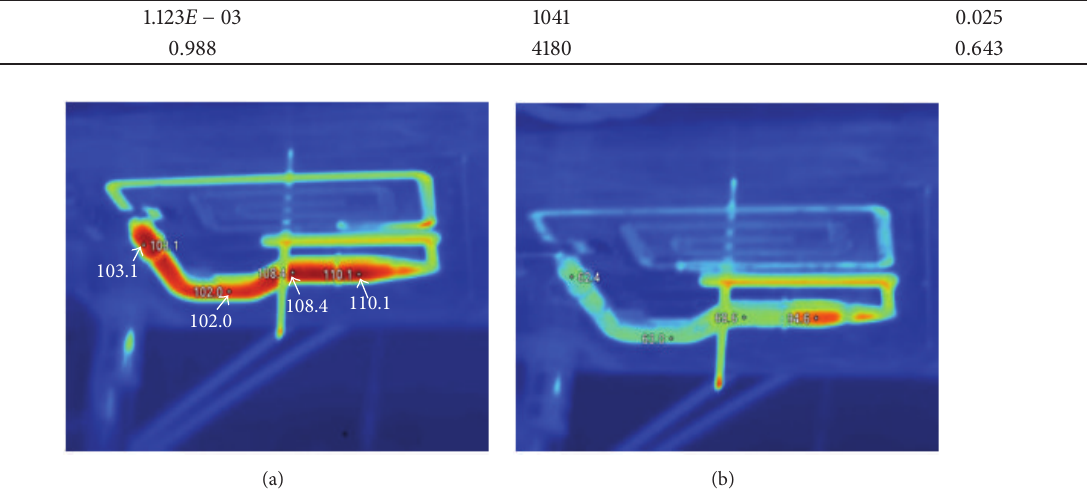
Figure 14: Comparison of the temperature distributions obtained by (a) GAIM and (b) WAIM.